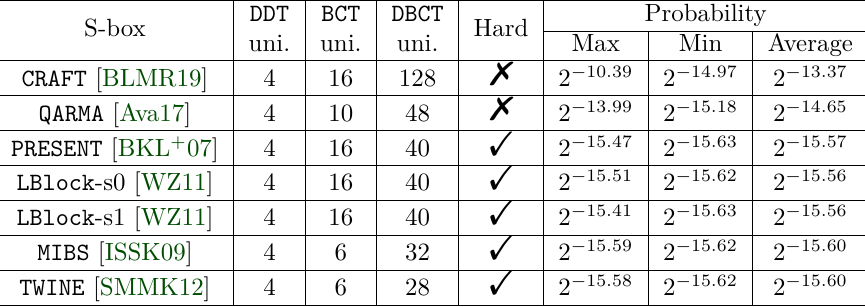
Table 4: Probability of the 7-round distinguisher with different S-boxes DDT BCT DBCT S-box